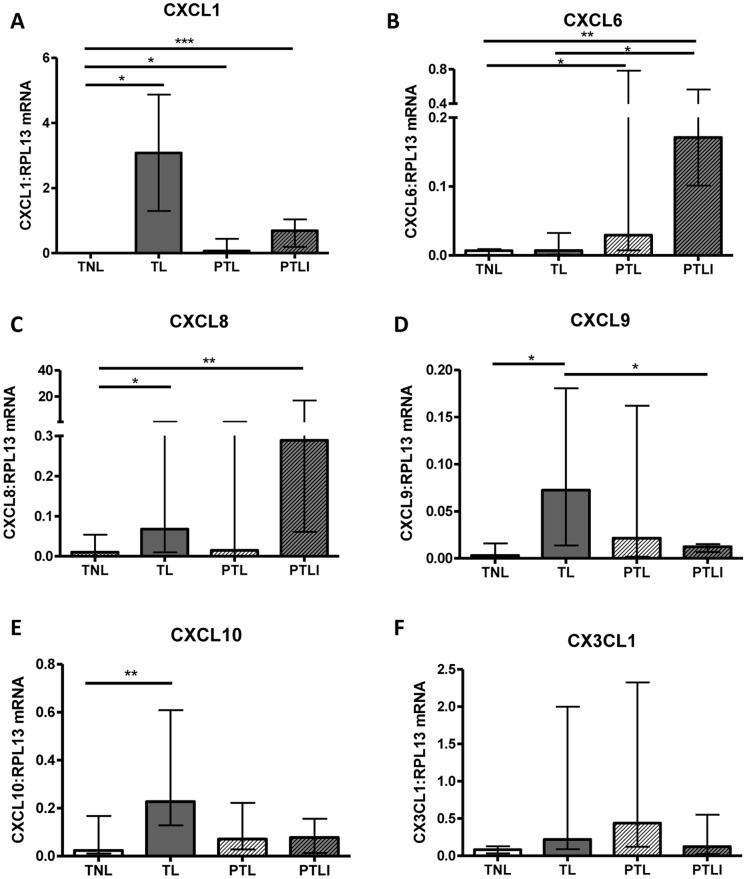
Choriodecidual CXC and CX3C chemokine mRNA expression in the four study groups.Chemokine mRNA expression was normalised to RPL13 mRNA expression levels. (A) CXCL1, (B) CXCL6, (C) CXCL8, (D) CXCL9, (E) CXCL10, (F) CX3CL1. Individual replicates and the median are shown, n = 10–14/study group. TNL = Term not in labour, TIL- Term labour, PTL = Preterm labour and PTLI = Preterm labour with infection. Data are median and interquartile range, *p<0.05 **p<0.01, ***p<0.001 (Kruskall-Wallis with Dunn’s post hoc test).